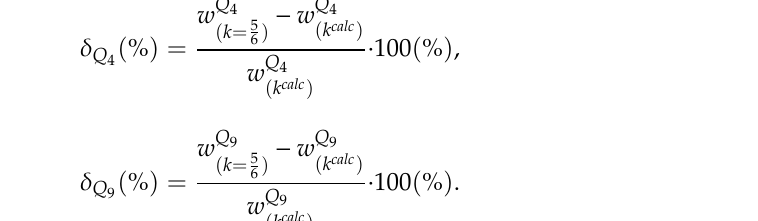
Figure 12. Porosity distribution models M2 and M3: evolution of the shear correction factor.